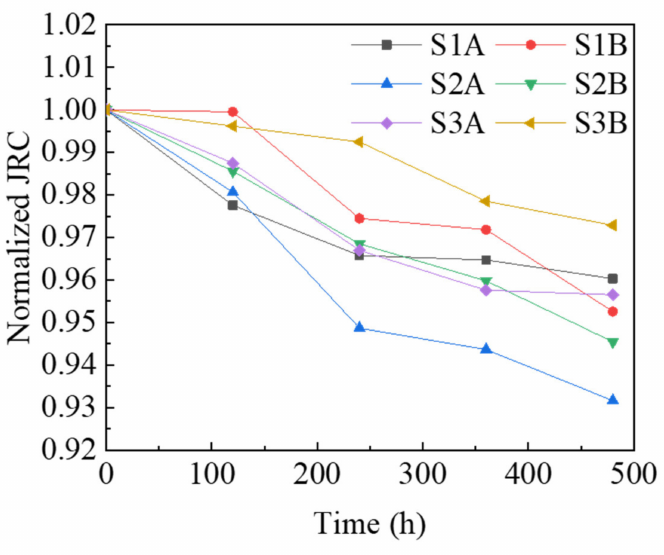
Figure 11. Temporal evolutions in fracture surface normalized JRC